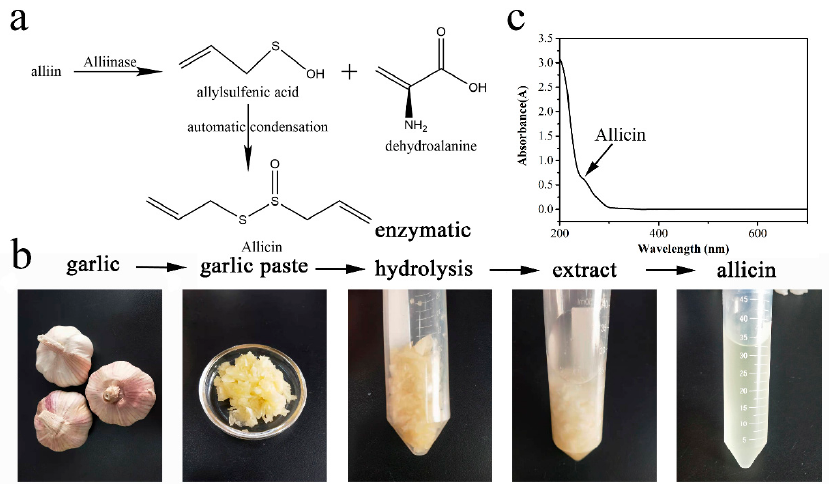
Figure 1. ( a ) Schematic illustration of allicin synthesis mechanism, ( b ) photographs of the allicin extraction process, ( c ) UV-vis spectrum of allicin in ethanol.